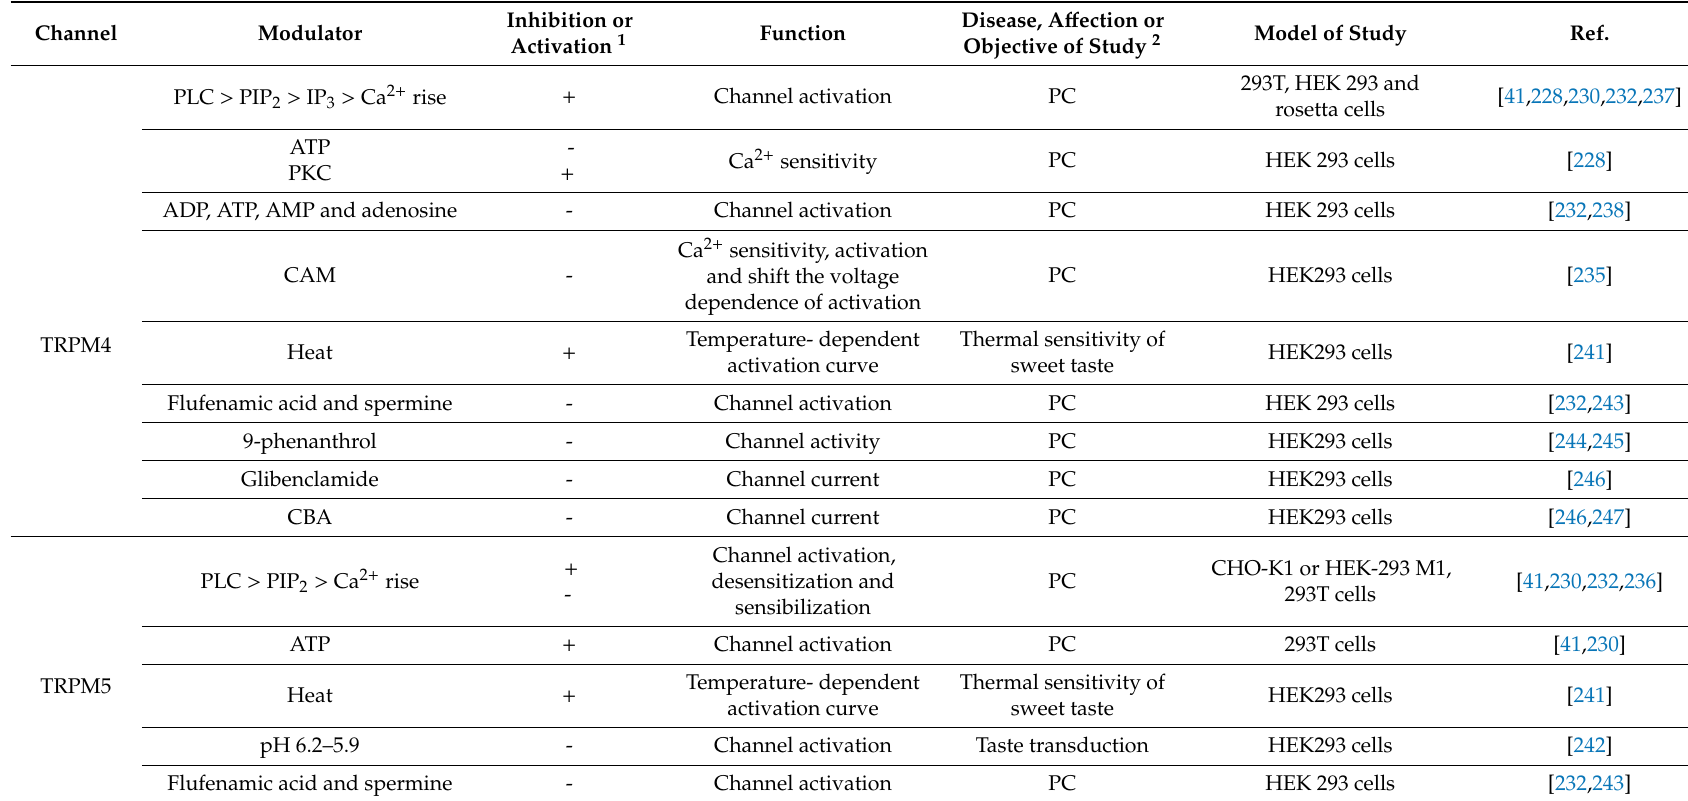
Table 3. Molecules modulating the activity of TRPM4 and TRPM5, participation in physiological processes and